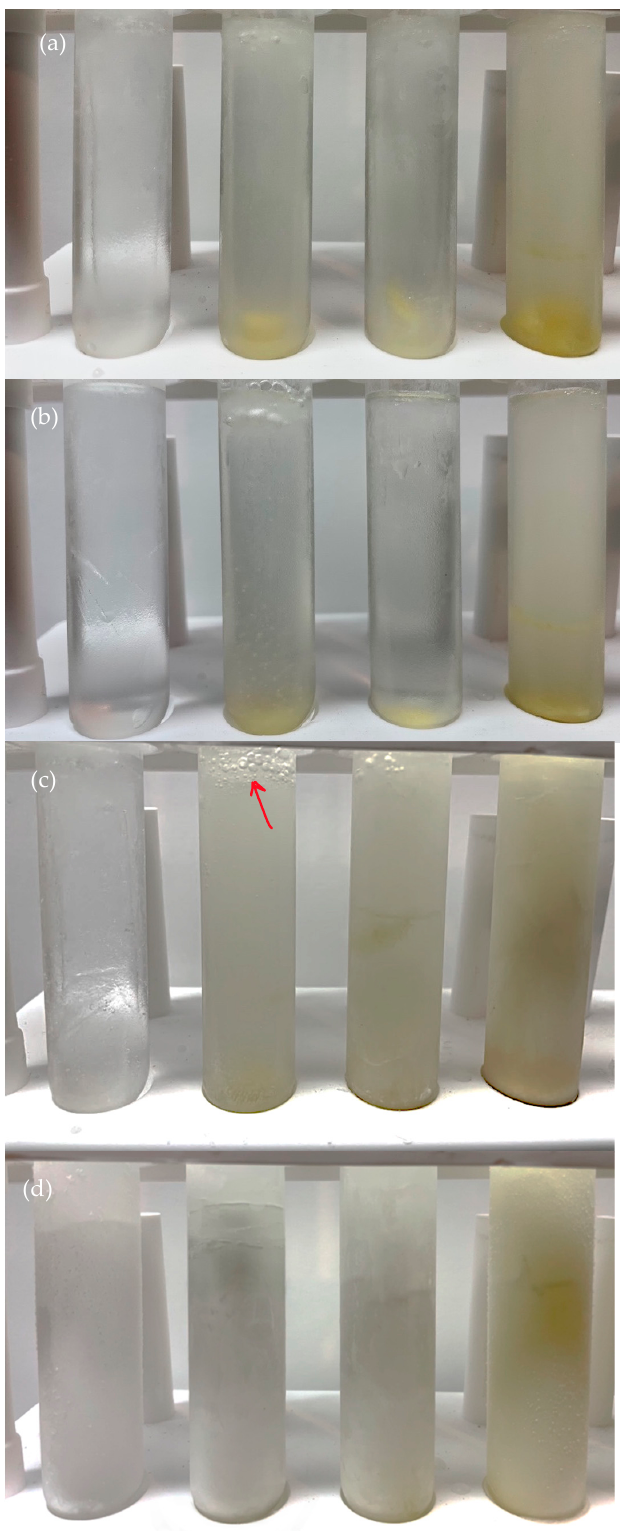
Figure 3. ( a – d ). PVA samples 1–4 after complete crystallization: ( a ) pure water and PVA 1 with 10%, 20%, and 50% PVA content by mass (left to right), ( b ) pure water and PVA 2 with 10%, 20%, and 50% PVA content by mass (left to right), ( c ) pure water and PVA 3 with 10%, 20%, and 50% PVA content by mass (left to right), ( d ) pure water and PVA 4 with 10%, 20%, and 50% PVA content by mass (left to